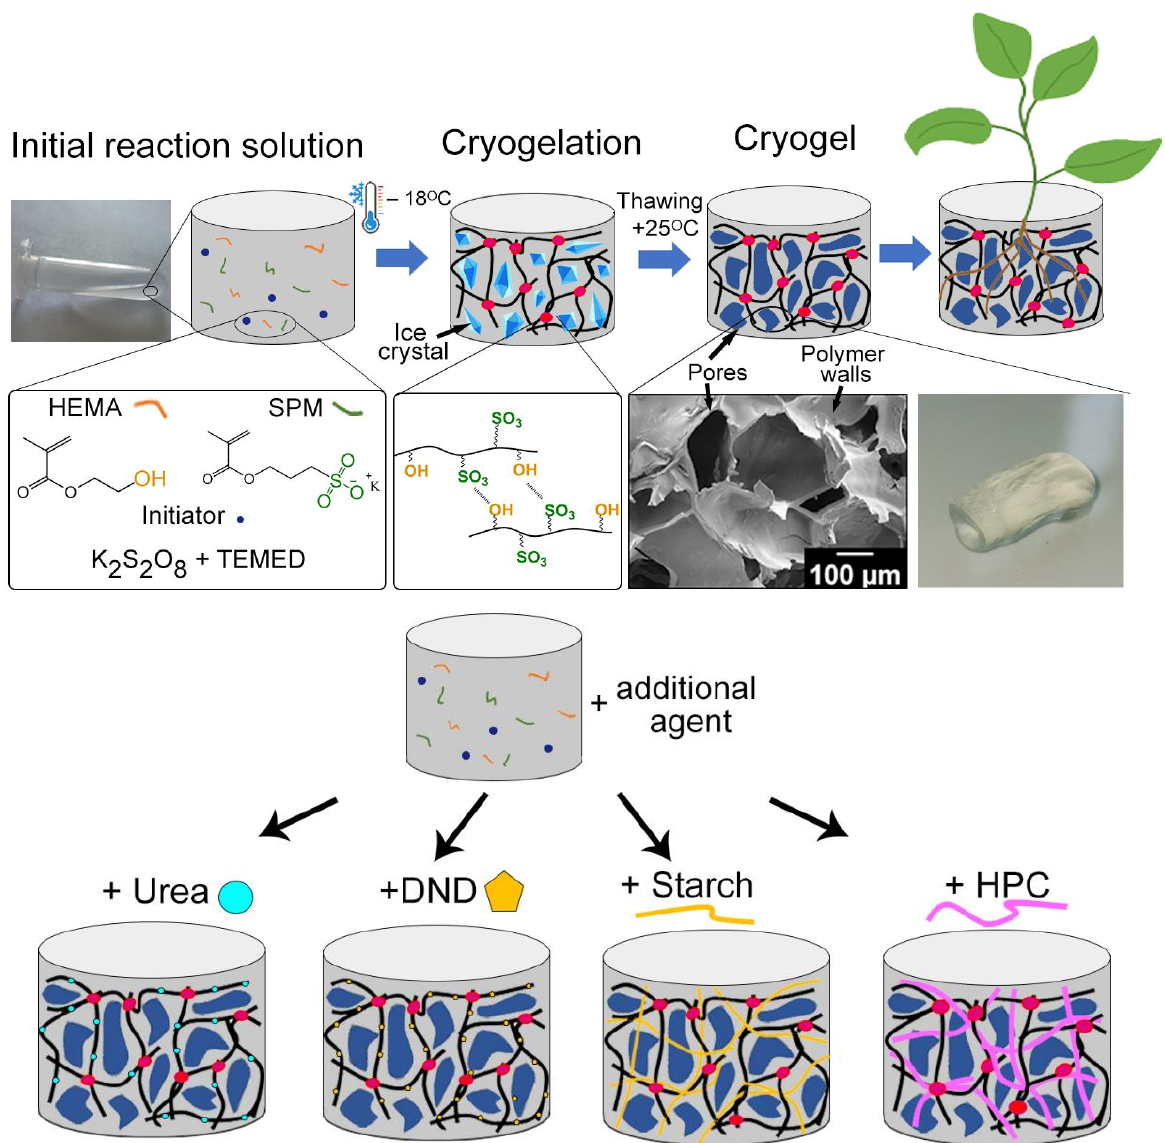
Figure 1. Scheme of cryogel synthesis and cryogel appearance. Table 1. Composition of the reaction system for the synthesis of P(SPM − HEMA) cryogels and cryo- gel characteristics.